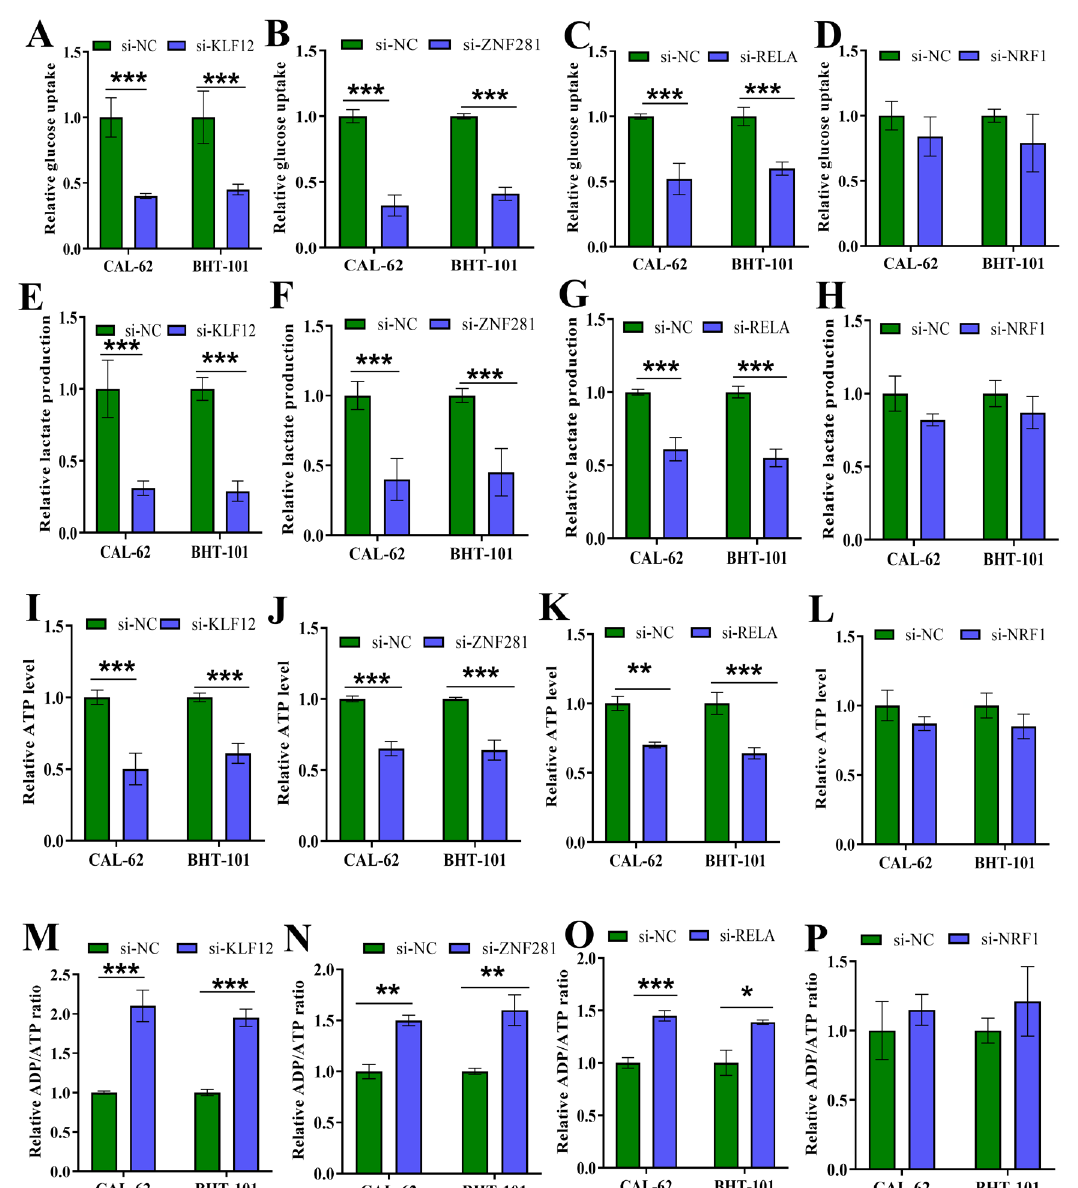
Figure 9. Effects of KLF12, ZNF281, RELA and NRF1 silencing on glucose metabolism in CAL-62 and BHT-101 cells. Relative glucose uptake (A-D), lactate production (E-H), ATP level (I-L) and ADP/ATP ratio (M-P) of CAL-62 and BHT-101 cells with or without KLF12, ZNF281, RELA and NRF1 silencing were measured. Comparison between two groups was conducted by Student’s t -test. *P<0.05, **P<0.01,